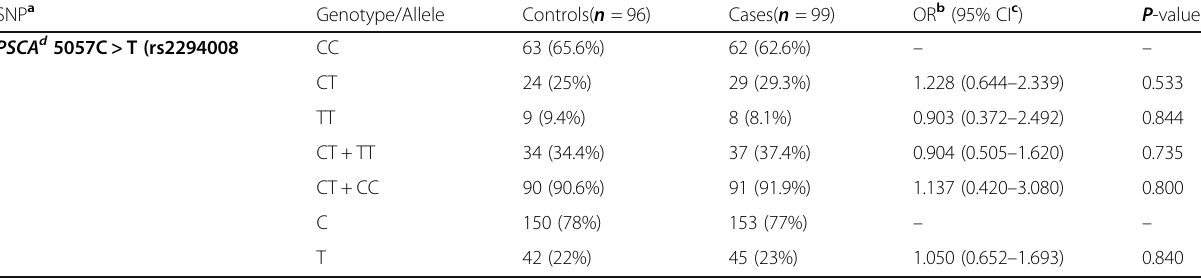
a. Single nucleotide polymorphisms, b. odds ratio, c. confidence interval,* Prostate stem cell